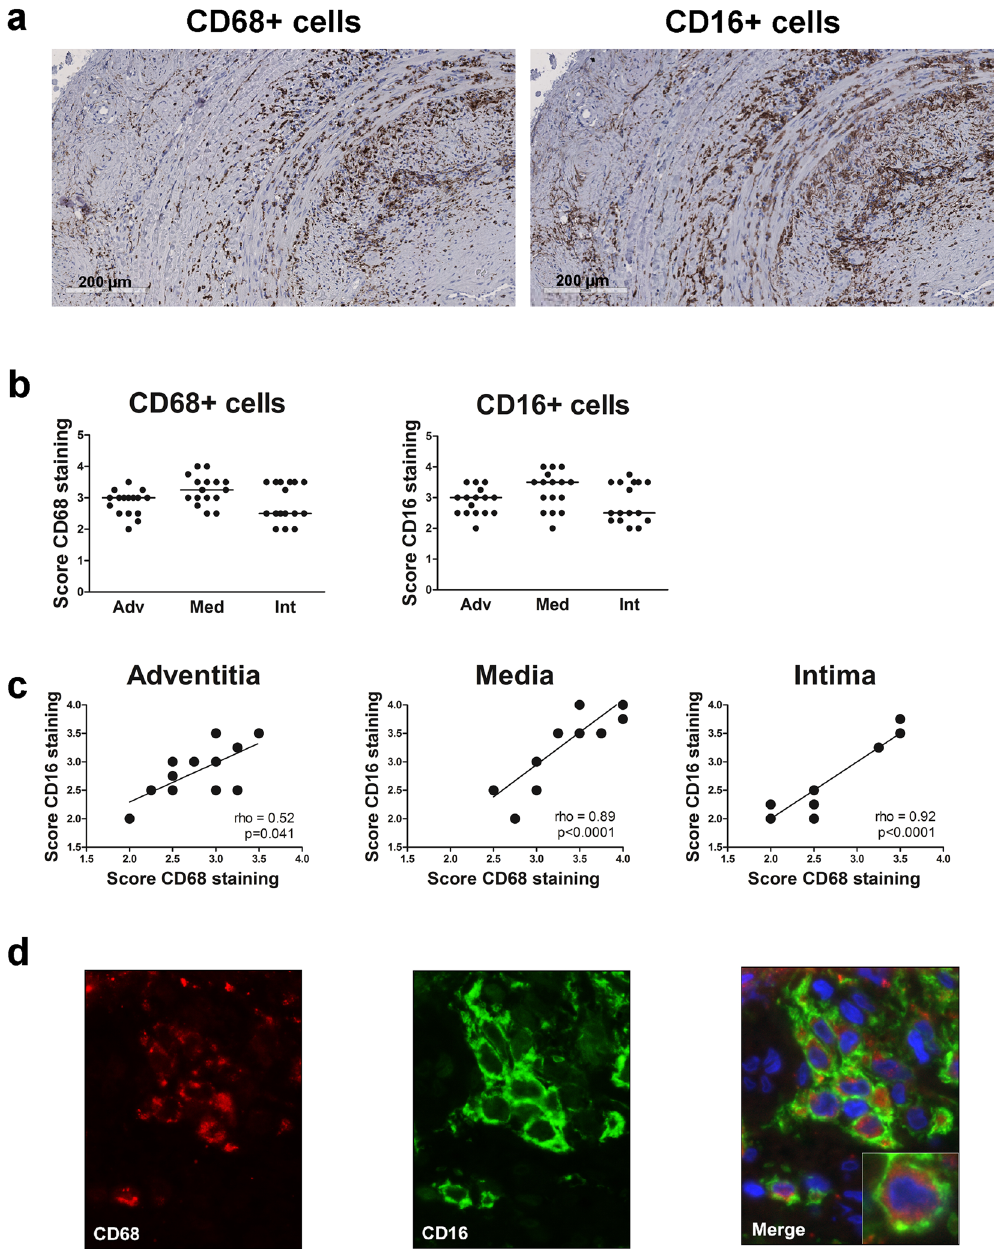
Figure 3. CD16 + cells co-localize with CD68 + macrophages in GCA temporal artery biopsies. ( a ) Immunohistochemical staining for CD68 and CD16 in a representative temporal artery biopsy (TAB) diagnostic of GCA. Note that consecutive sections of the same tissue were used in Figs 3 and 5. ( b ) Semi- quantitive mean scores of CD68 + cells and CD16 + cells in inflammatory areas of GCA TABs (n = 16). Scores are given for the adventitia (Adv), media (Med, infiltrating cells only) and intima (Int). Data are presented as scatter plots. The horizontal line indicates the median. ( c ) Positive correlation between CD16 and CD68 scores in intima, media and adventitia in inflammatory areas of GCA TABs (n = 16), as determined by Spearman’s rank correlation coefficient. Due to overlap in semi-quantitative scores not all 16 scores can be appreciated. ( d ) Single staining for CD68, CD16 and double staining for CD16 and CD68, respectively, from left to right in the inflammatory area of a TAB section. An example of a magnified merged picture is shown for clarity. Blue = DAPI staining of nuclei; Green (FITC) = CD16 expression, Red (AF555) = CD68 expression; a macrophage cytoplasmic granules